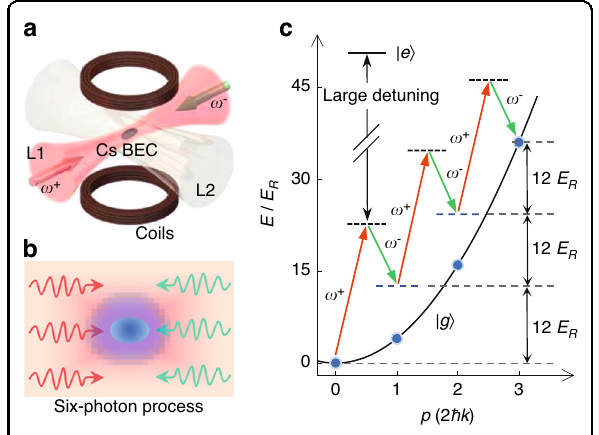
Fig. 1 Experiment setup and schematic for high-order Bragg spectra. a Sketch of experimental setup. A 133 Cs BEC is prepared in a quasi-1D optical trap that consists of two nearly orthogonal 1064-nm laser beams (L1 and L2) with the different 1 /e radius. A pair of counter-propagating Bragg lasers, which are formed by retro- re fl ecting the trap laser beam (L1), are used to illuminate the optically trapped BEC for implementing Bragg spectra. b Schematic of third-order Bragg diffraction involved with the six-photon process. The atom absorbs three photons from the incident laser beam and simultaneously radiates three photons into the retro- re fl ected laser beam. c Illustration of energy diagram in the third- order Bragg resonance. Three stimulated Raman transitions are simultaneously driven for directly coupling the zero-momentum BEC to the momentum state p = 6 ħ k , and the energy difference is evenly divided into each transition laser beam, the frequency ω − of retro-re fl ected laser beam